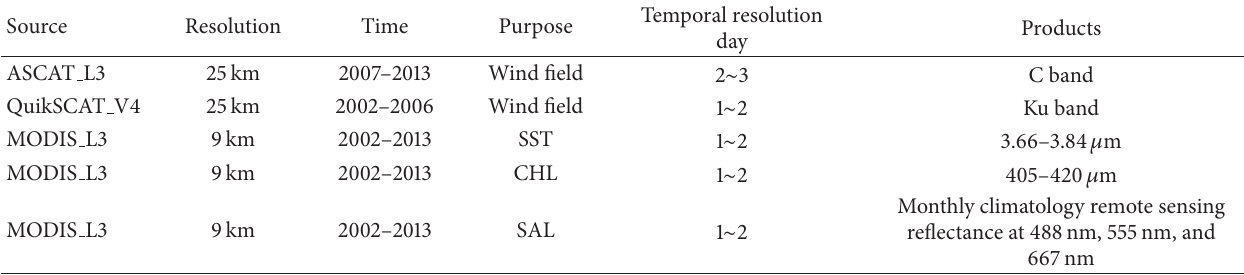
Table 1: Remote sensing data used in this